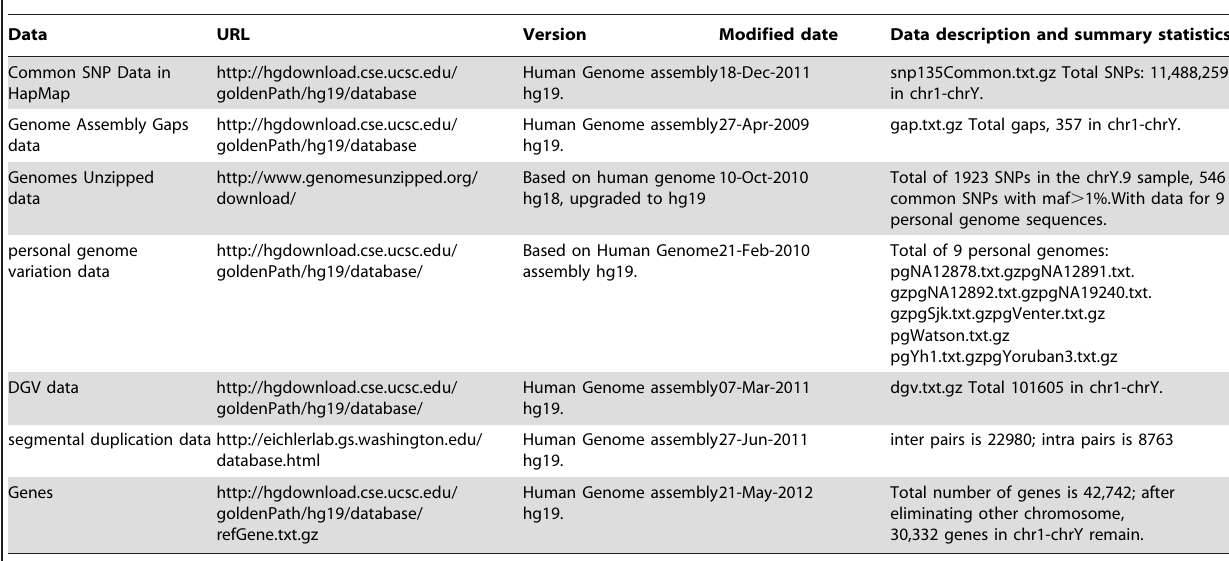
Table 1. Data Sources Used in This